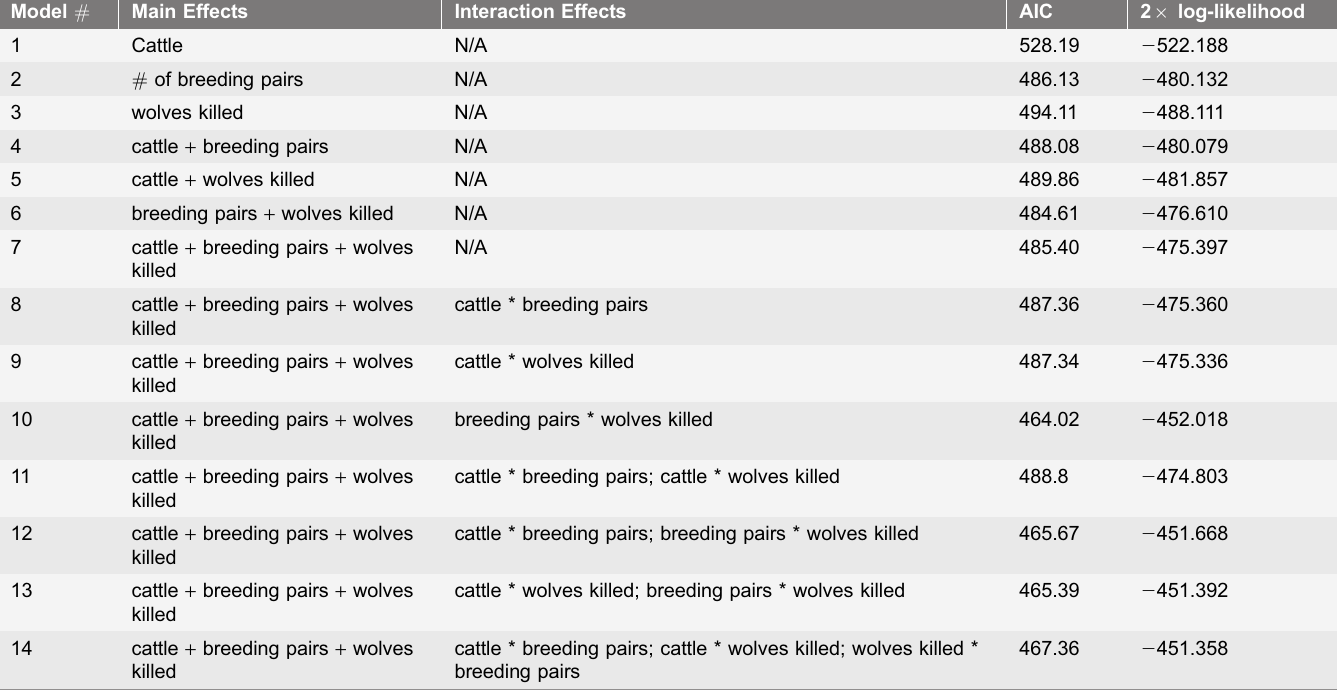
Table 1. AIC and log-likelihood values for forward selection of main effects and interaction effects models of cattle depredations Model